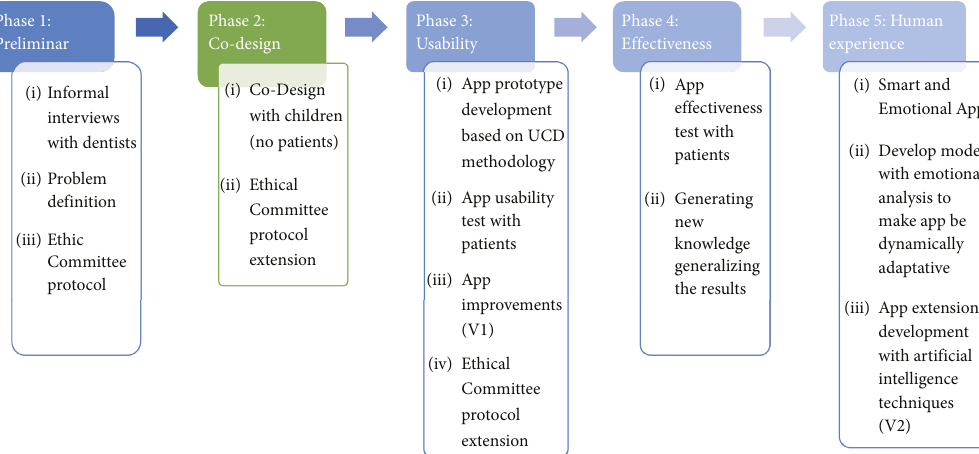
Figure 2: ARCADE project phases (scheme). This work deals with phase 2: codesign